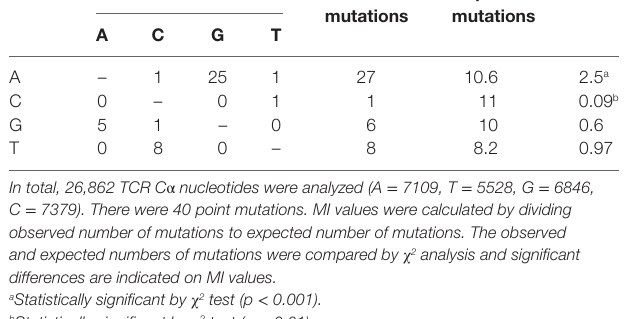
TaBle 4 | Substitutions and mutability index (MI) of T cell receptor V α mononucleotides. From substitutions Observed expected mutations